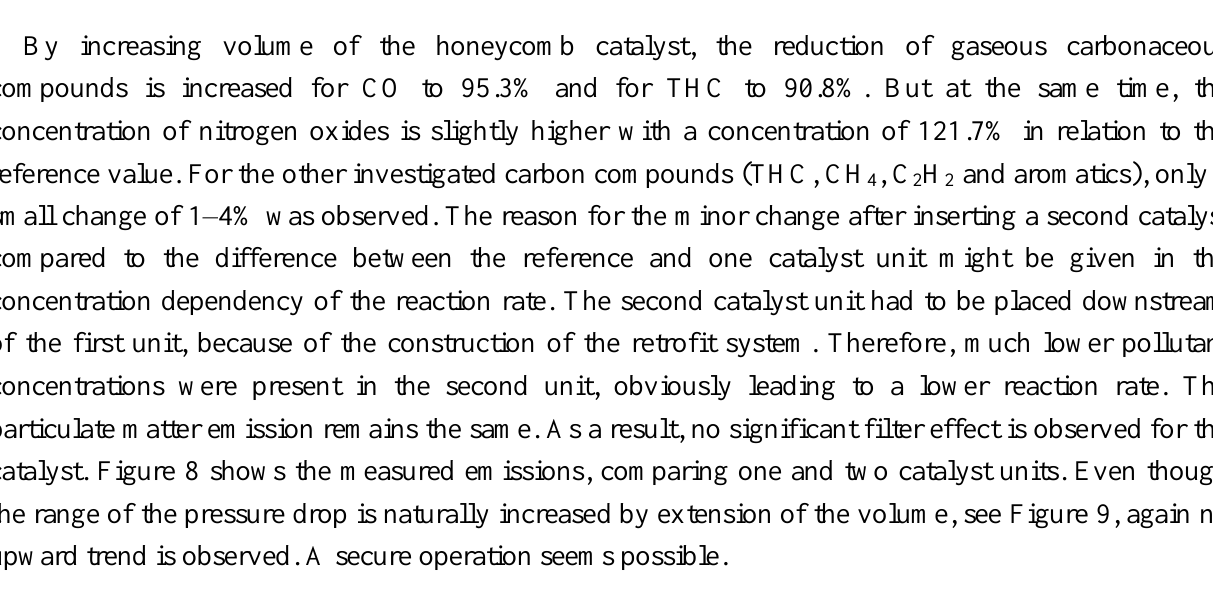
Figure 8. Comparison of the concentrations of selected pollutants and of oxygen in the exhaust stream for one and two catalyst units (black bars: one catalyst unit; red bars: two catalyst units. * The measurement unit of the particulate matter concentration is mg Nm −3 and for all other pollutants